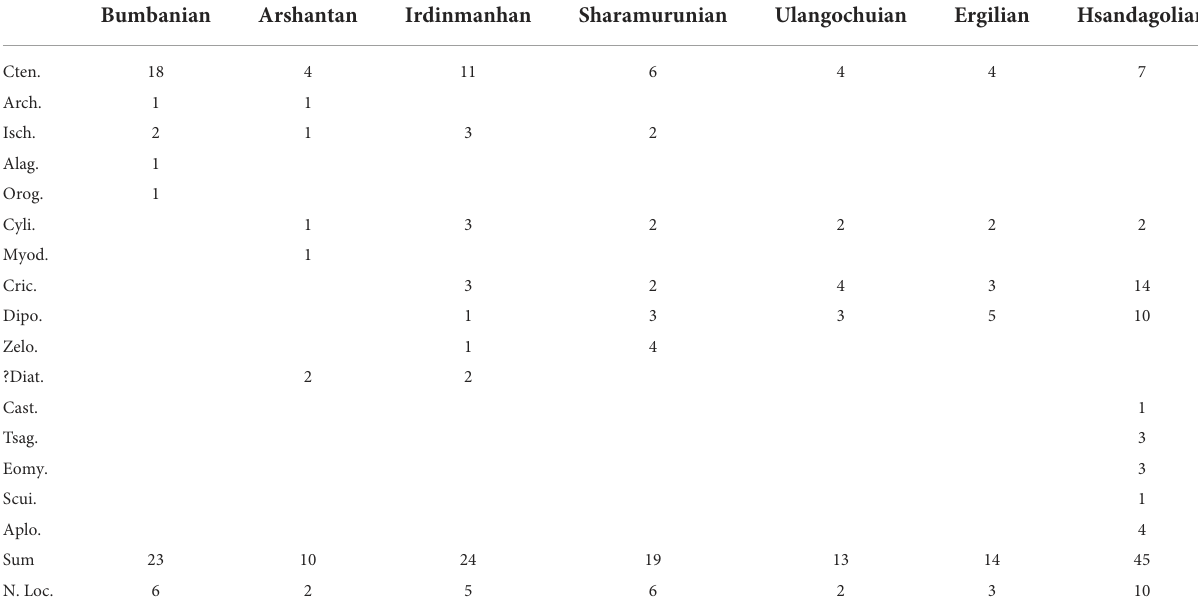
TABLE 2 Generic numbers of different rodent groups from early Eocene to early Oligocene in East Asia.